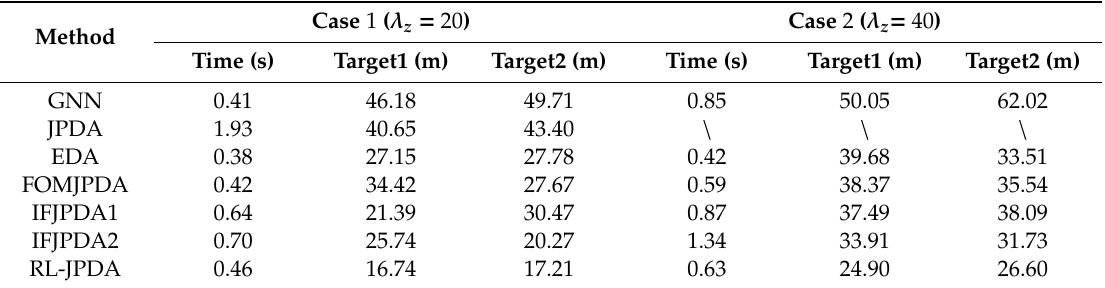
Table 1. Root mean square (RMS) errors and execution time of the two